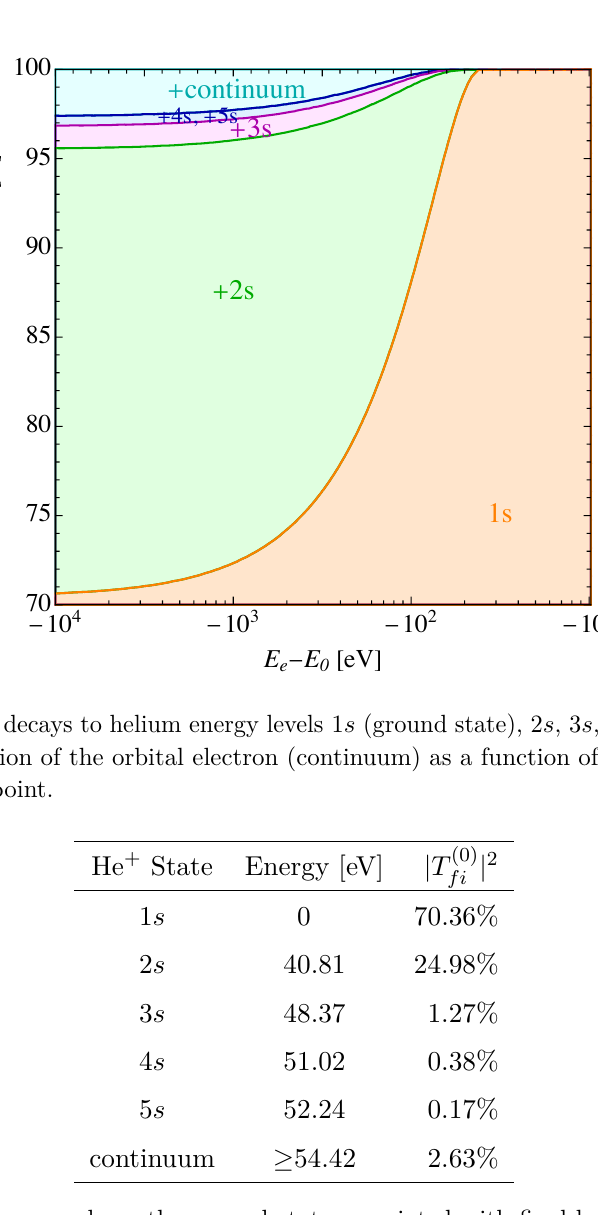
Table 3 . Excitation energy above the ground state associated with final helium orbital electron states and the corresponding asymptotic branching ratios for large β -electron